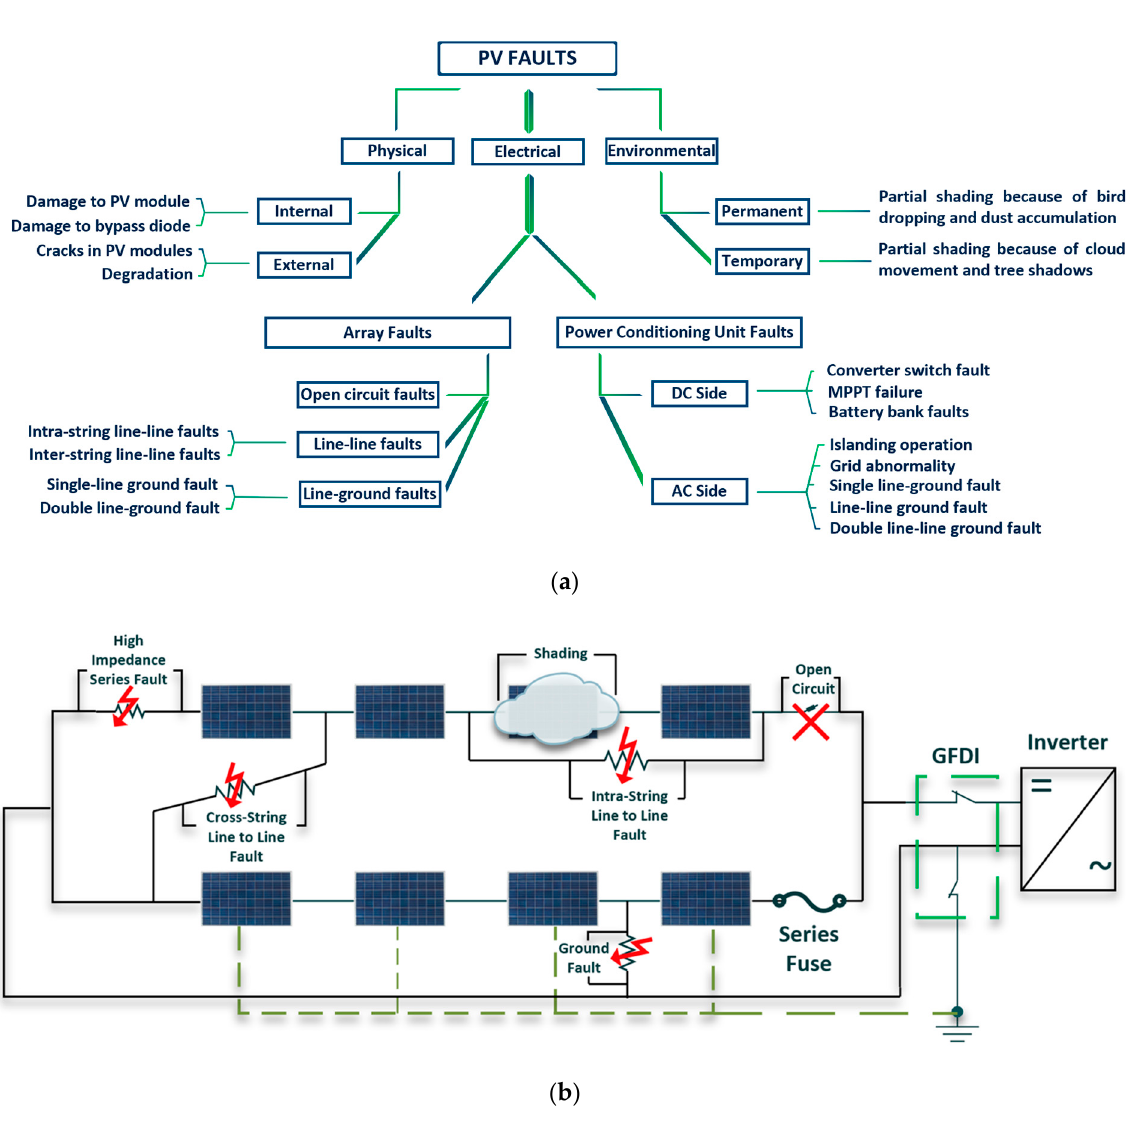
Figure 4. ( a ) Various faults on PV system; ( b ) Types of faults that can occur in PV system and the use of GFDI device.